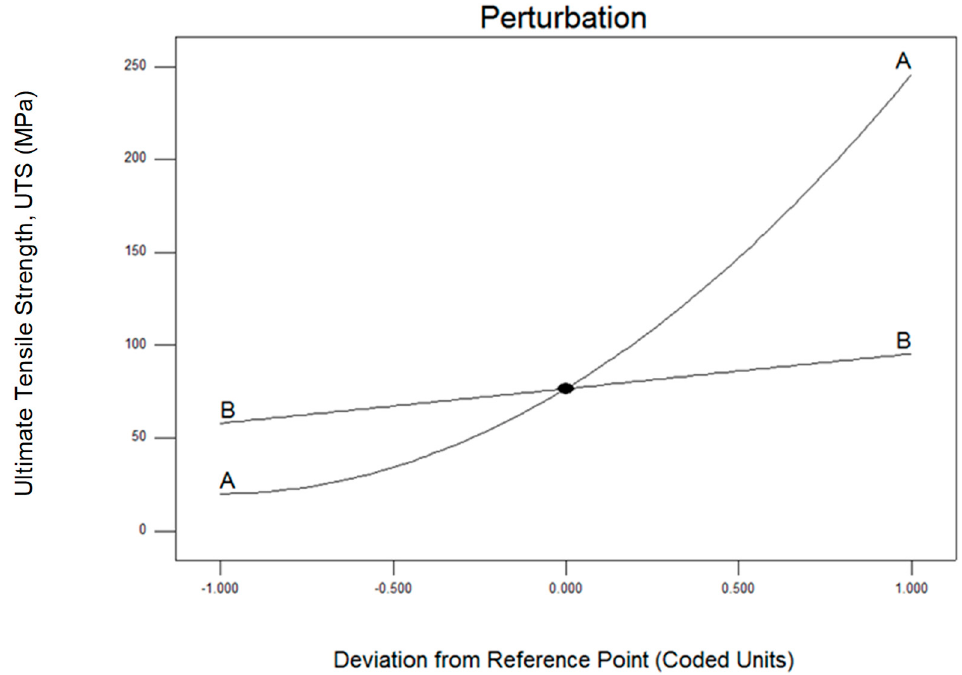
Figure 3. Perturbation plotted graph as a correlation of ( A ) operating temperature and ( B ) holding time for ultimate tensile strength (UTS).